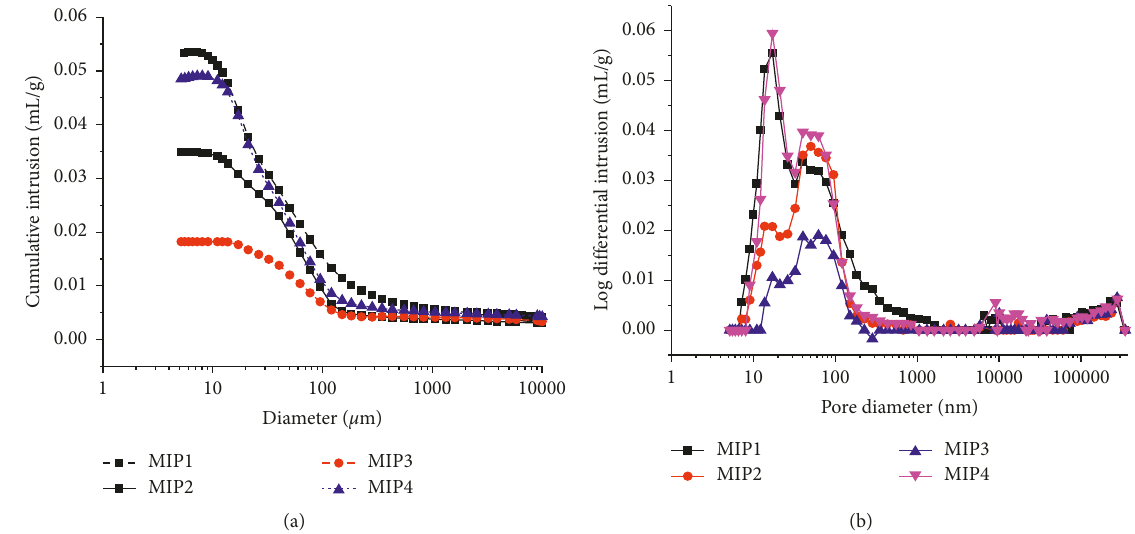
Figure 8: Pore size distribution of hardened cement paste by MIP: (a) cumulative curve; (b) relative